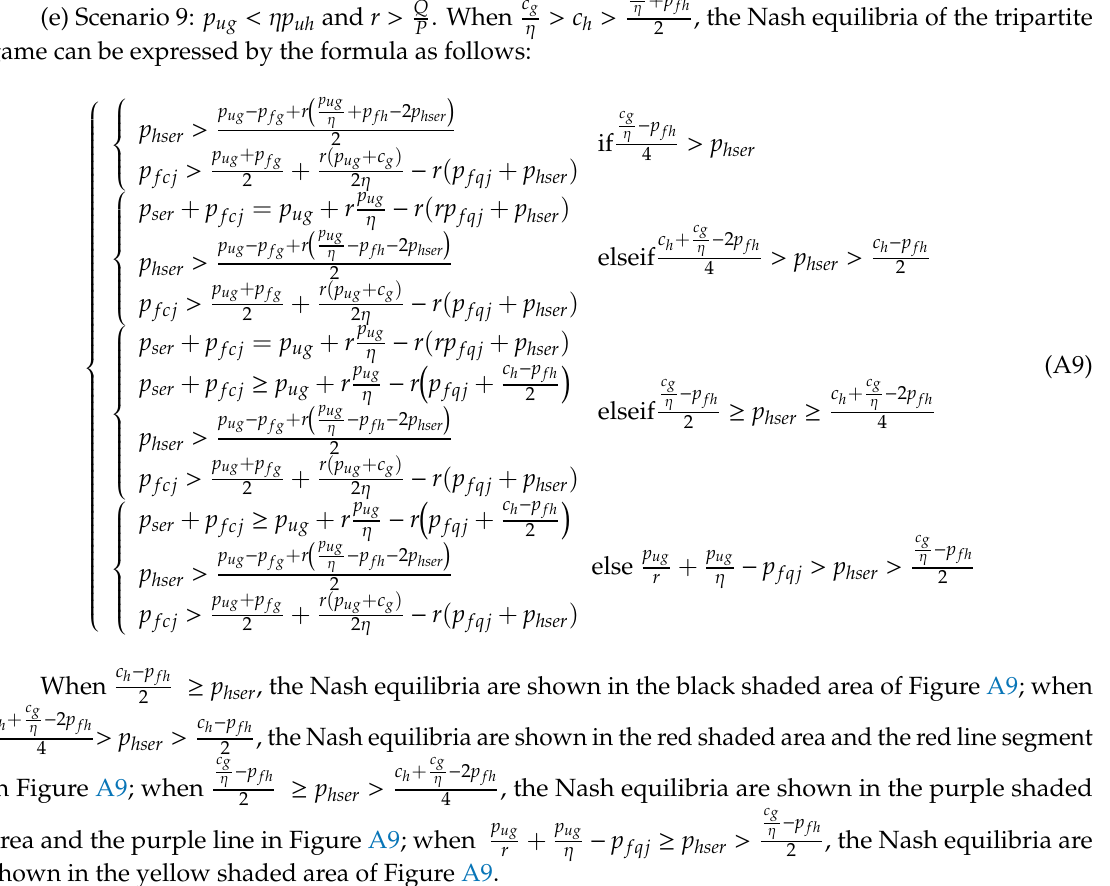
area and the purple line in Figure A9; when shown in the yellow shaded area of Figure